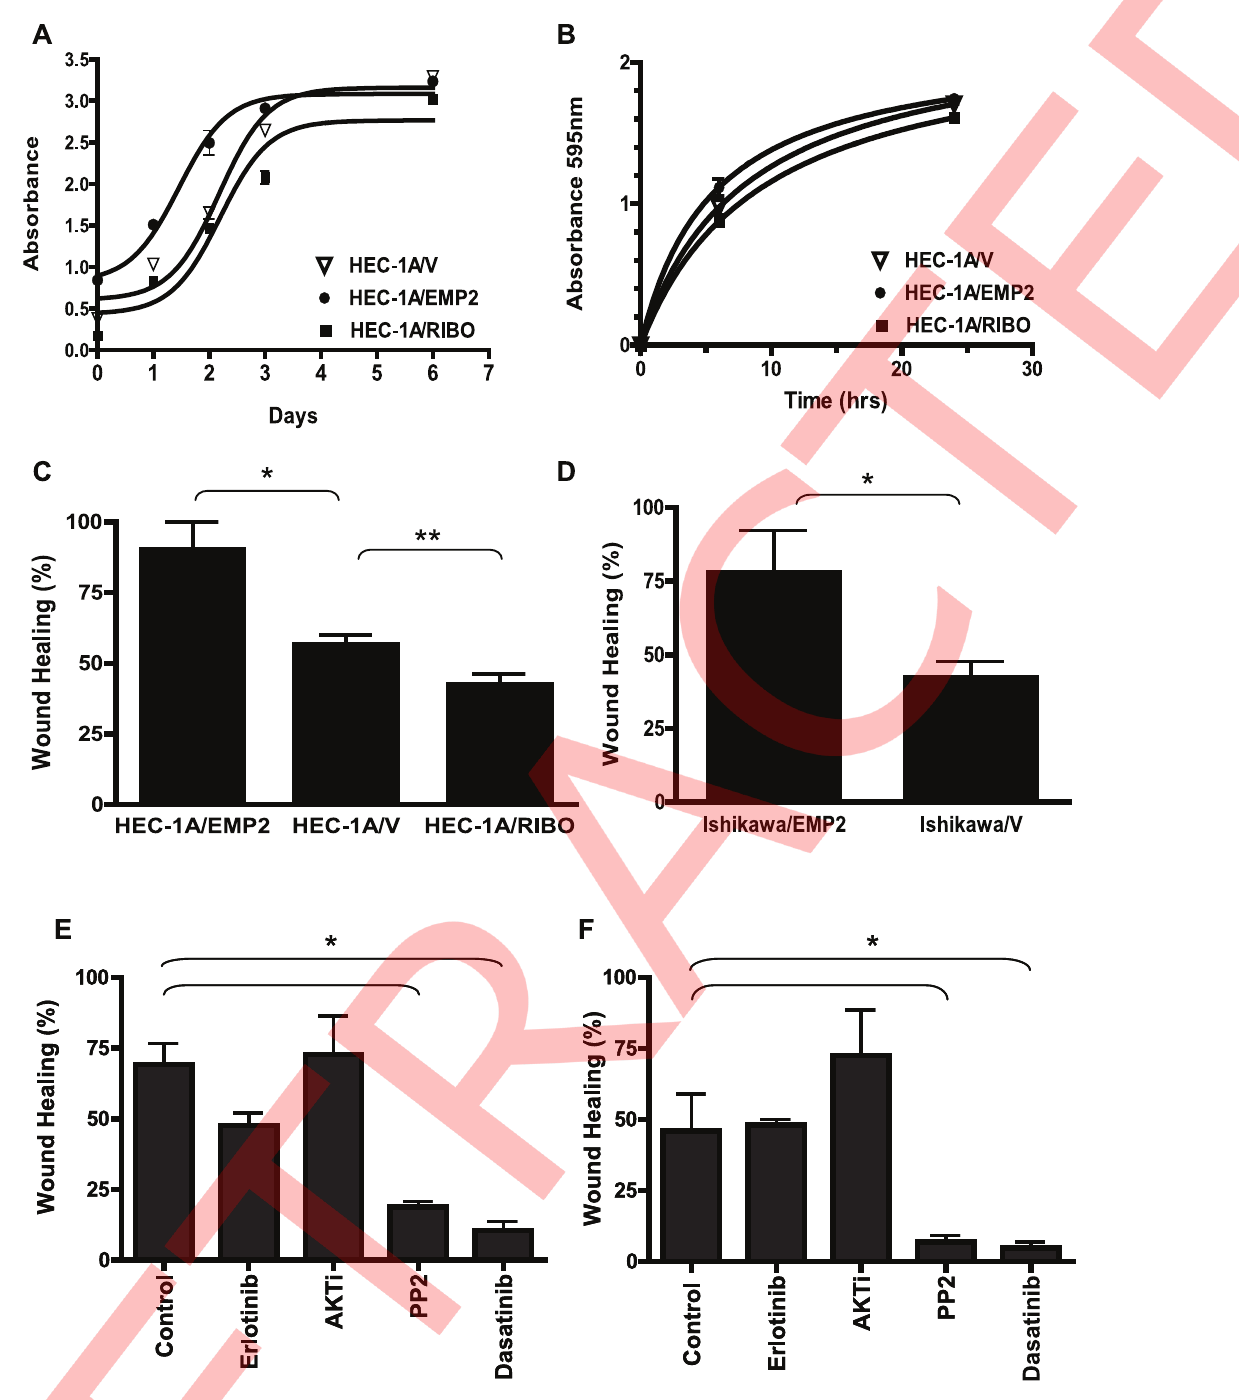
Figure 2. EMP2 expression and FAK/Src signaling promote wound healing. (A) HEC-1A/EMP2, HEC-1A/V, and HEC-1A/RIBO cells were analyzed quantitatively for total cell numbers from 0–7 days or (B) BrdU incorporation after 2 or 24 hours. No significant differences in cellular proliferation or total cell numbers were observed between the three cell lines. The experiment was repeated at least 3 times with similar results. (C) HEC-1A/EMP2, HEC-1A/V, or HEC-1A/RIBO cells were grown in a monolayer and then a ‘‘wound’’ created. After 24 h, wound closure was measured. Experiments were performed at least three times, and the results averaged. Comparison by Student’s t test, * p=0.03; ** p=0.05. (D) The same experiment was also performed on Ishikawa/EMP2 and Ishikawa/V. Comparison by Student’s t test, * p=0.02. (E) HEC-1A cells were grown to reach a confluent monolayer. Cells were incubated with the PP2, Dasatinib, Erlotinib, AKTi VIII, or a vehicle control, and a wound created. After 36 h, plates were imaged, and the percentage of wound closure was calculated. Values are averages ( 6 SEM, n=3). Comparison by Student’s t test, * p , 0.05. (F) The same experiment was also performed on Ishikawa cells. Values are averages ( 6 SEM, n=3). Comparison by Student’s t test, * p , 0.05.